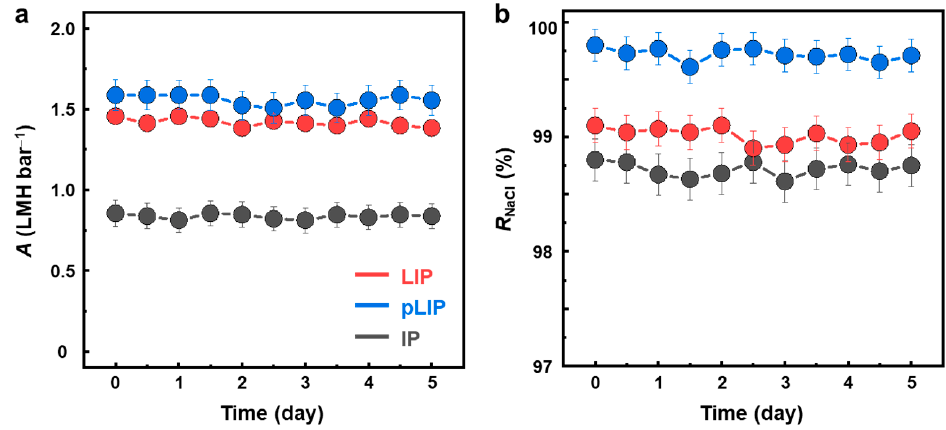
Figure 5. Long-term operational stability of the fabricated membranes. ( a ) Water permeance ( A ) and ( b ) NaCl rejection ( R NaCl ) of the optimized LIP, pLIP, and conventional IP membranes for 5 days of RO operation.